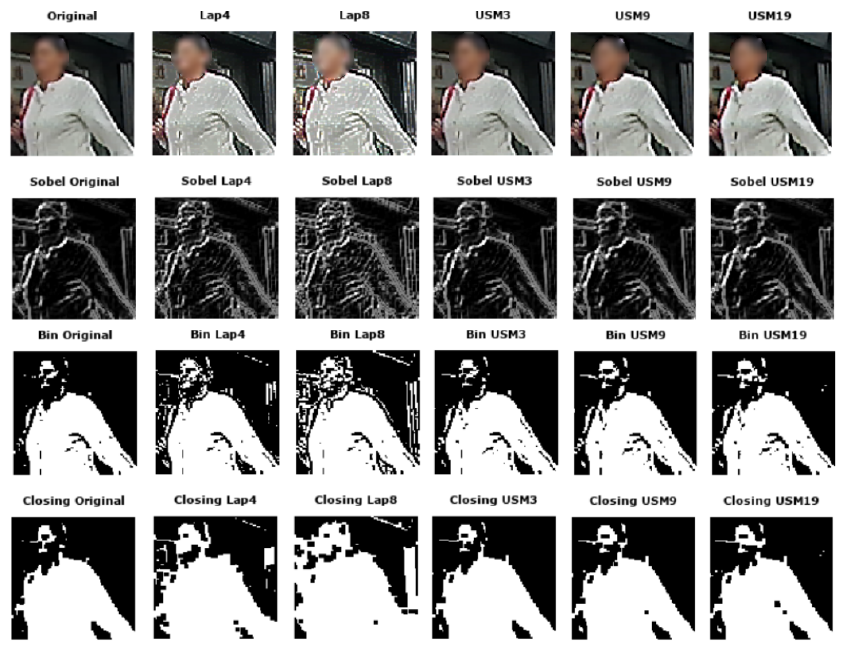
Figure 10. Samples of sharpened images with various